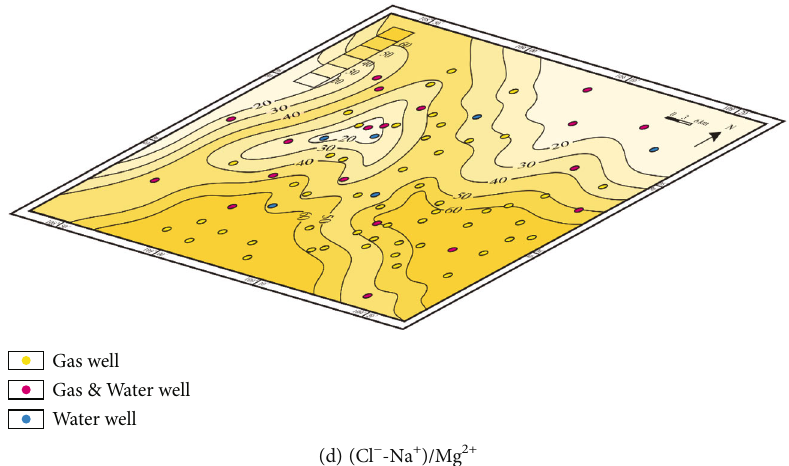
Figure 12: Correlation between geochemical properties of formation water and gas/water well